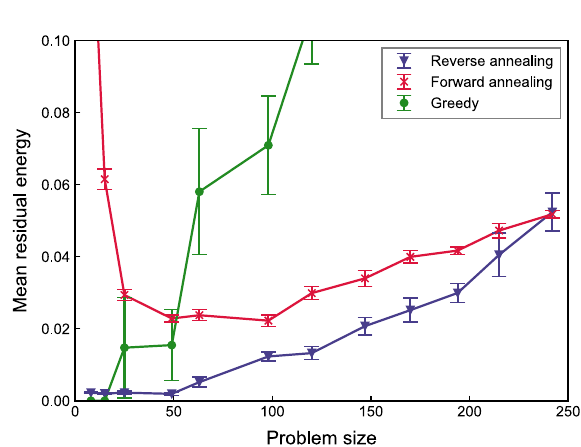
Figure 5. Comparison of residual energy. The purple triangle, red cross, and green circle show mean residual energy of samples on 10 problems solved by reverse annealing, forward annealing, and the greedy algorithm, respectively. The error bars indicate the standard